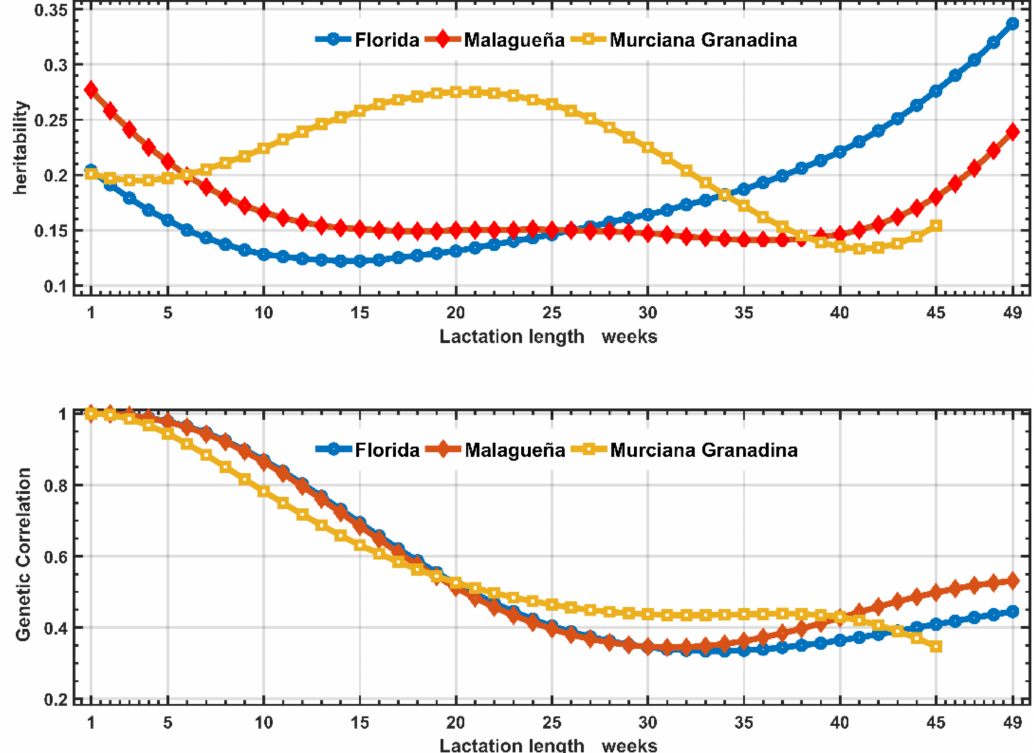
Figure 3. Estimates of heritability and genetic correlations between the first week of lactation and the rest of lactation obtained with the classic Test Day Model (model 1) in three Spanish breeds of goats.